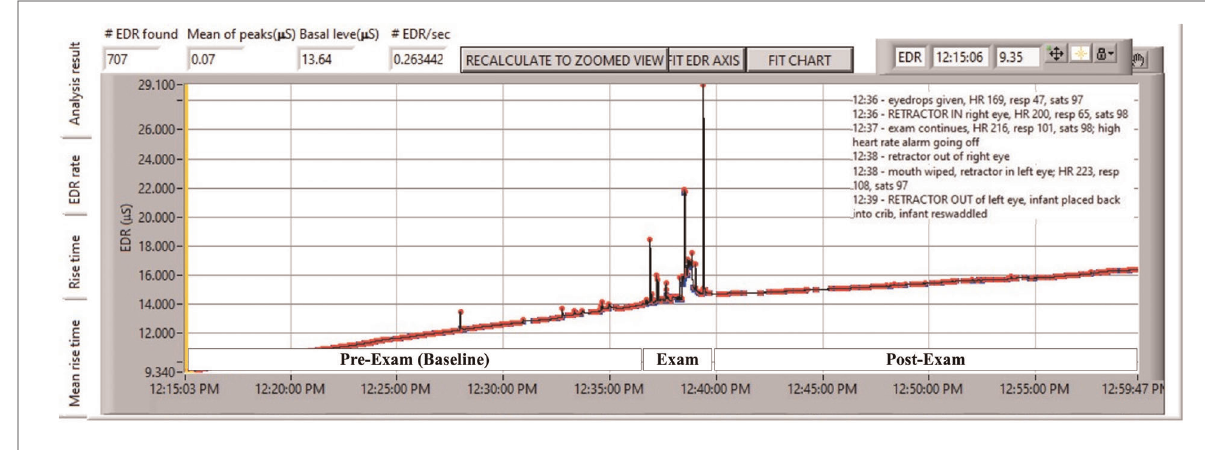
FIGURE 1 Representative subject showing continuous skin conductance before, during, and after ROP examination. ROP examination re fl ects noxious effects of anesthetic eye drops, lid retraction, scleral indentation and retinal visualization, retractor removal from the fi rst eye and insertion into the second eye, scleral indentation and retinal visualization to lid retractor removal from the second eye. Each waveform peak (or electrodermal response, EDR) is indicated by a red marker. The frequency of peaks divided by the time of the epoch in seconds is EDR/sec or peaks/sec . The average height of peaks is represented as mean of peaks .